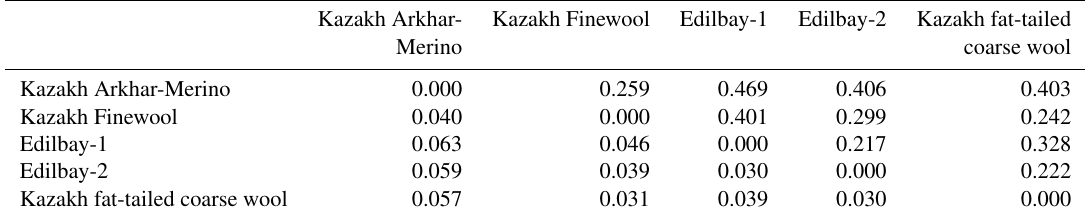
Table 3. Pairwise population matrix of Nei’s genetic distances (above the diagonal) and pairwise population F st Values (below the diagonal). Kazakh